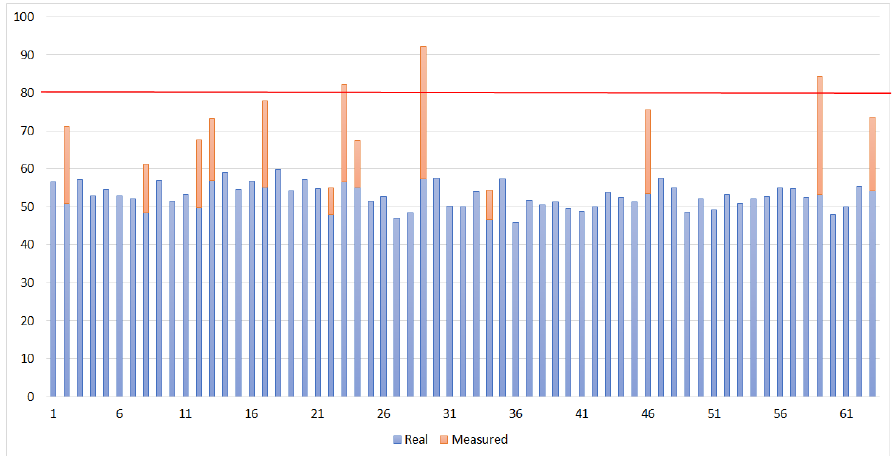
Figure 19. Measurement temperature ( ◦ C) profile and